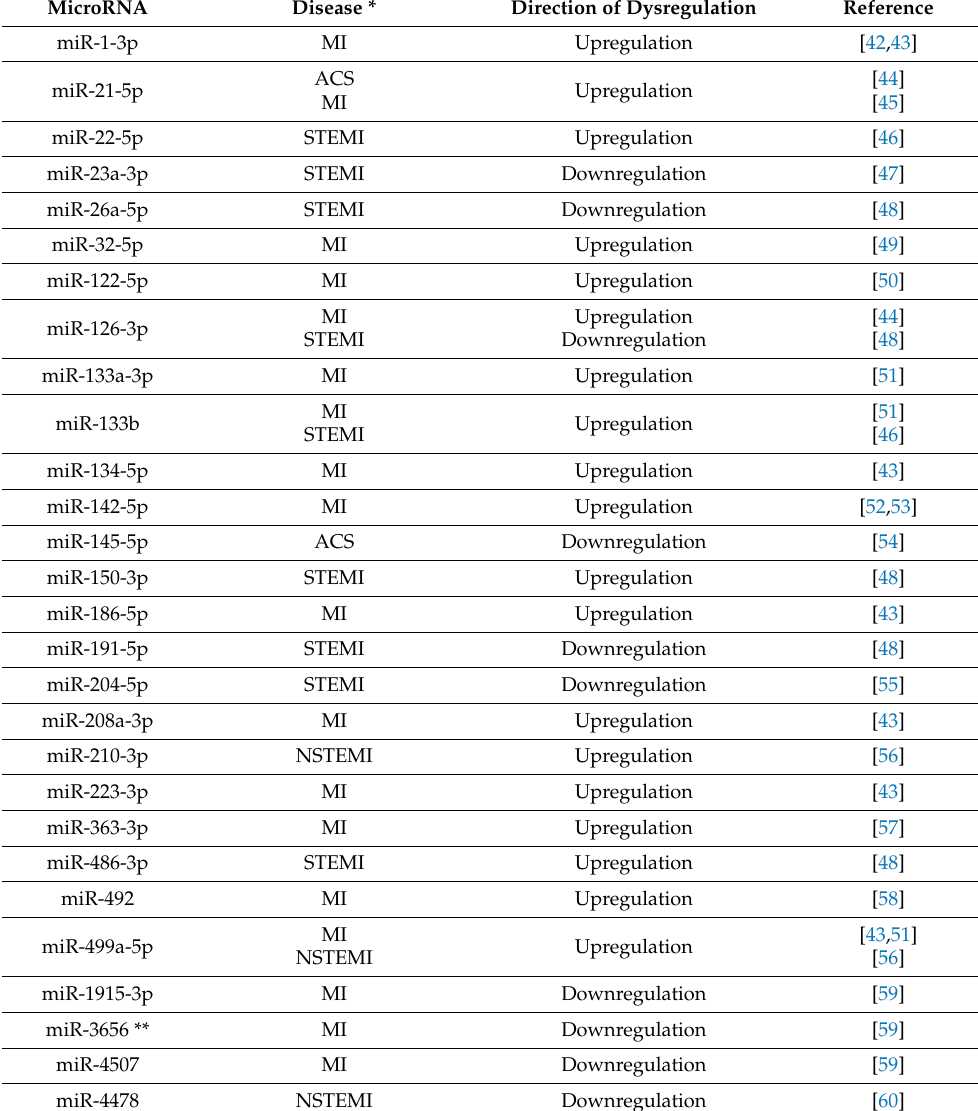
Table 1. Potential diagnostic serum microRNAs for myocardial infarction from literature review. MicroRNA Disease